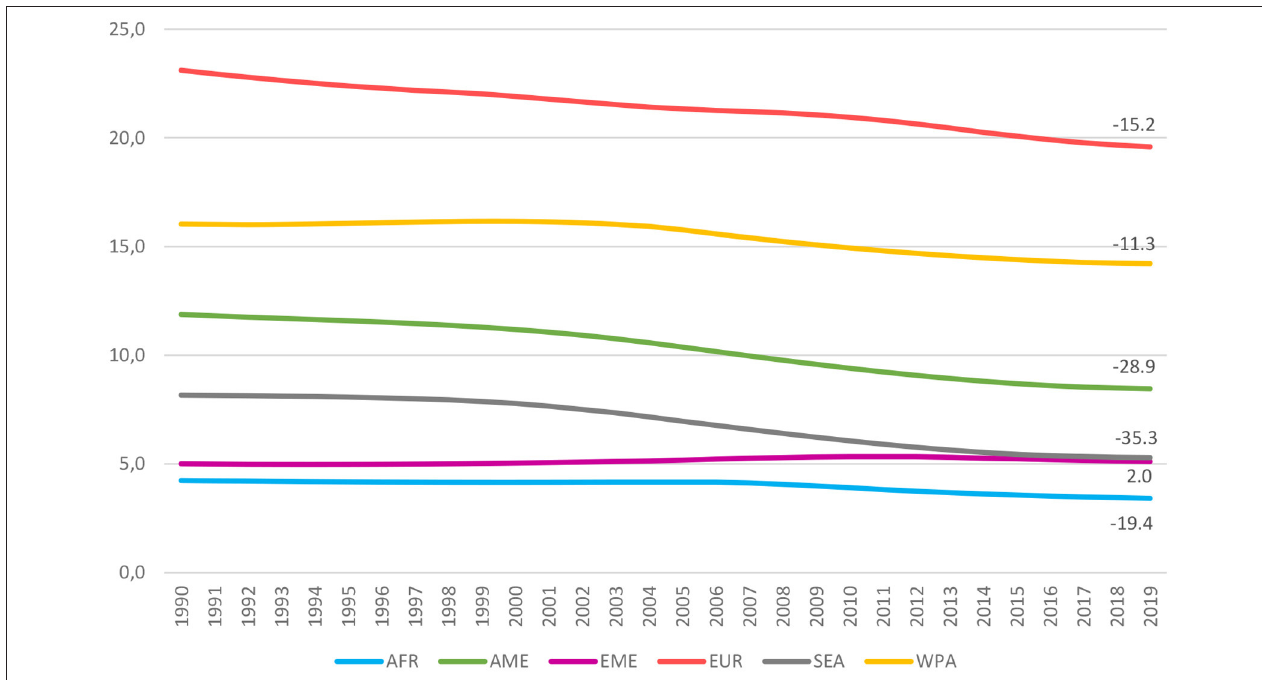
FIGURE 1 | Prevalence of smoking tobacco use among women (by WHO’s regions, 1990–2019). Age-stand. rate of smoking tobacco use in the female populations (aged 15 years and older). WHO regions: African (AFR), Americans (AME), Eastern Mediterranean (EME), European (EUR), South-East Asian (SEA), and Western Pacific